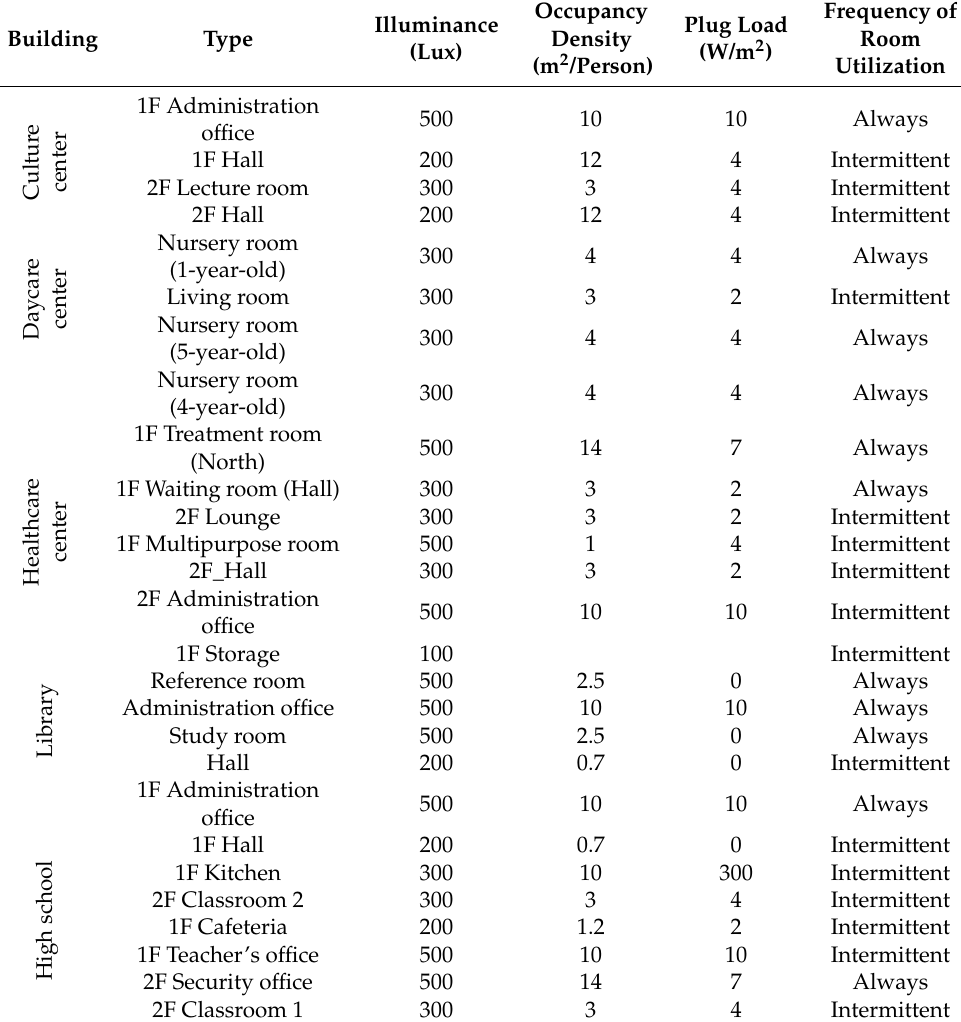
Table 4. List of internal conditions for each